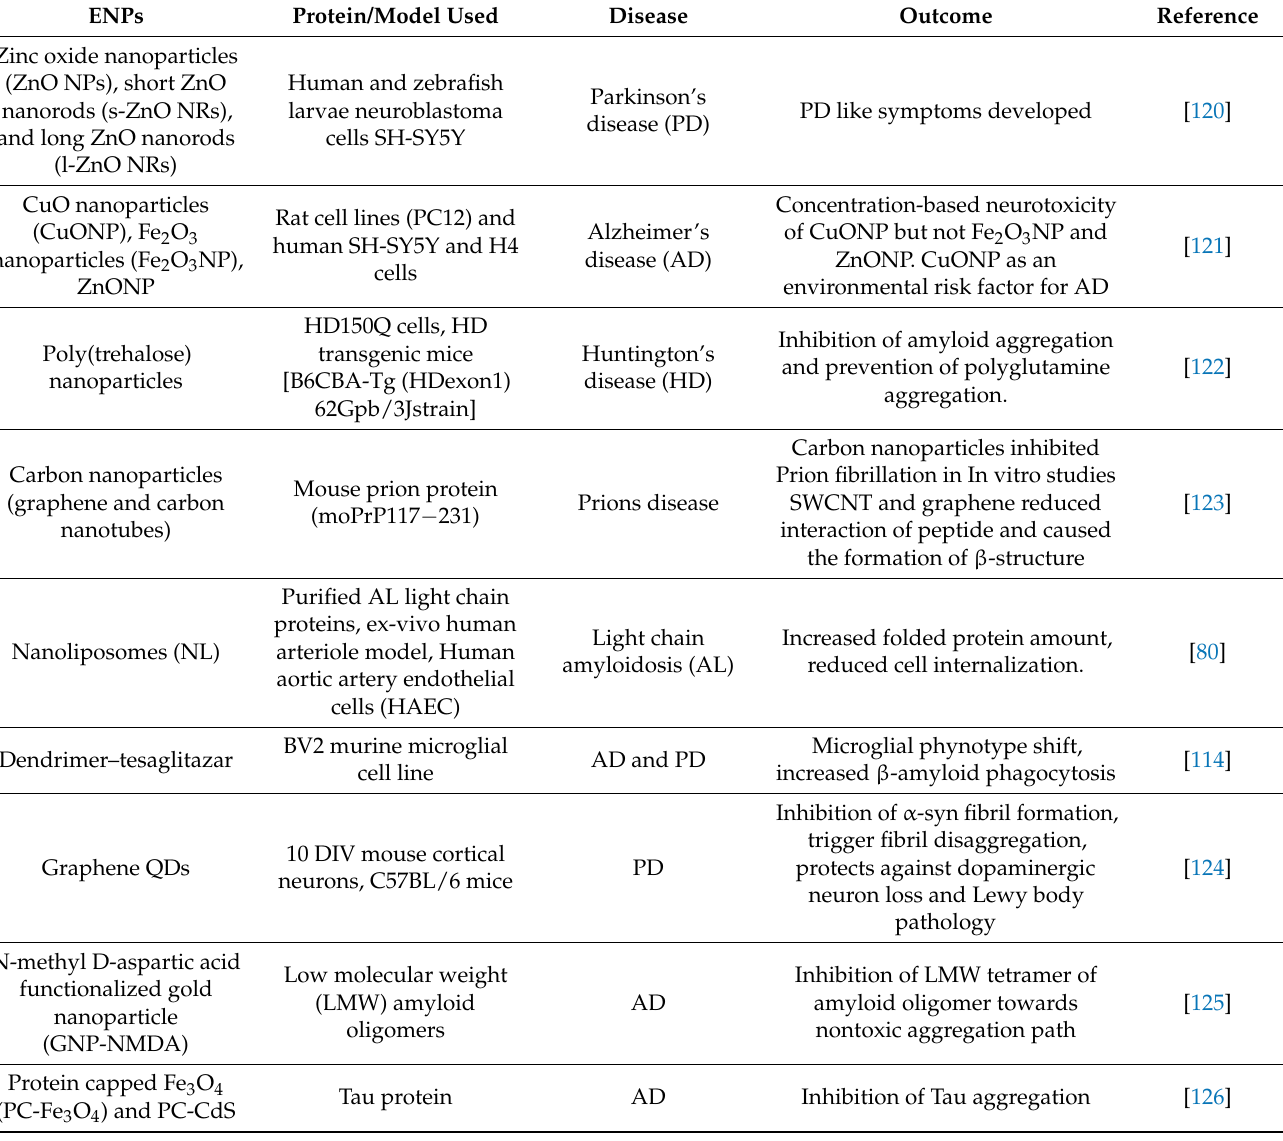
Table 3. Studies showing involvement of ENPs in protein